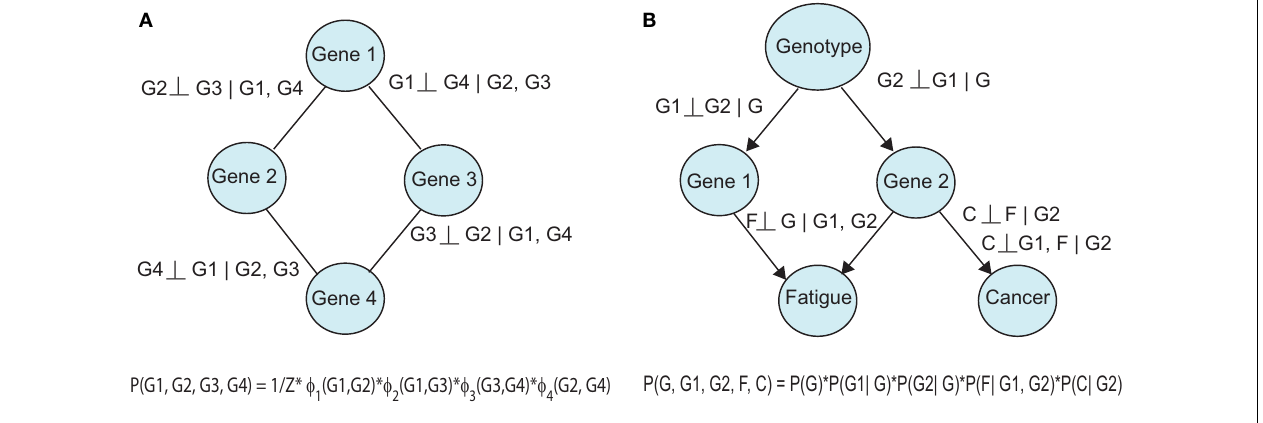
FIGURE 2 | Probabilistic graphical models can be (A) undirected, or (B) directed. Relationships between variables can be expressed using conditional independencies, allowing compact representation of the joint